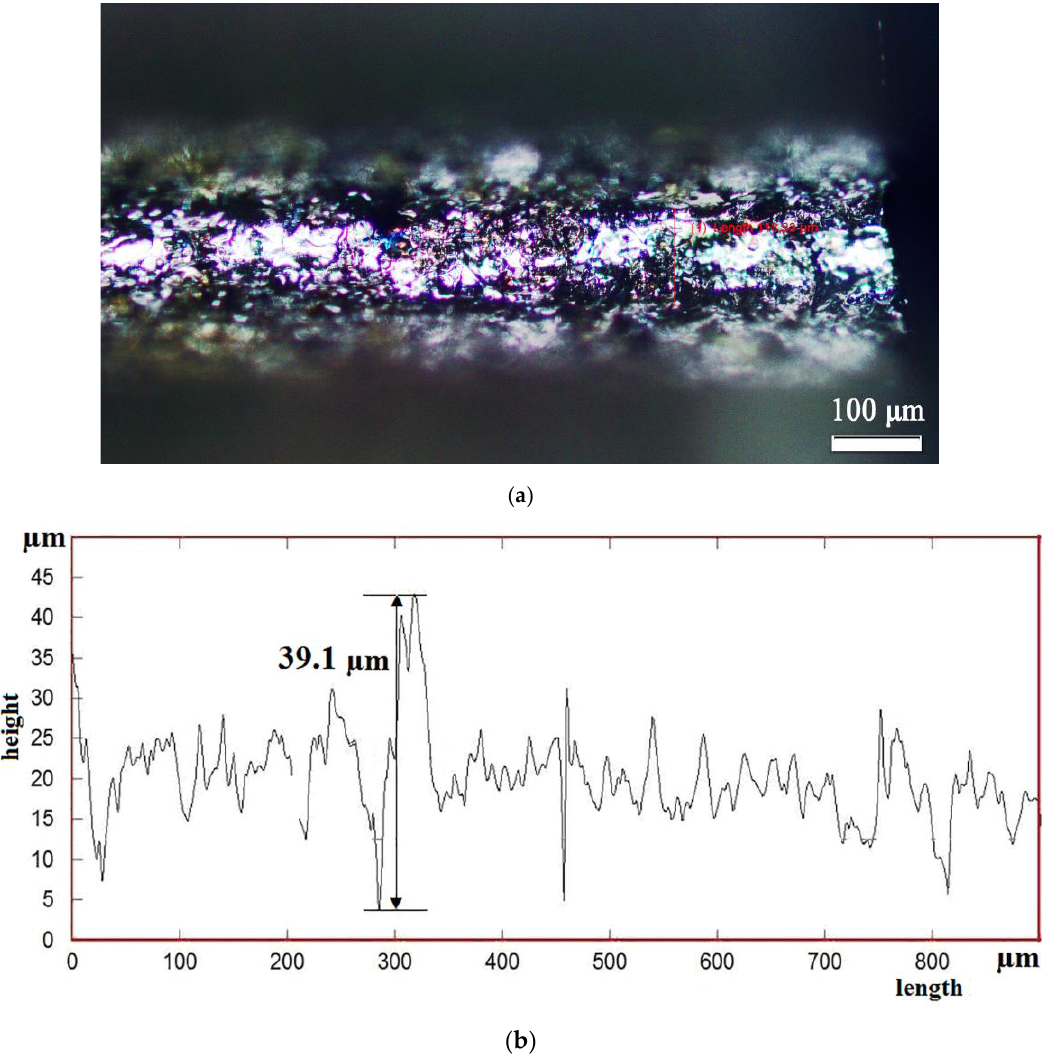
Figure 18. Trace left by the wire electrode on the surface after its break: ( a )—photo of the trace; ( b )—profilogram of the